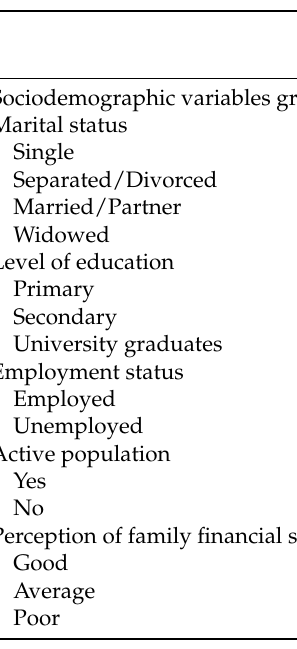
Table 1. Descriptive analysis of the study variables in the regions of Madrid, Cantabria and the Canary